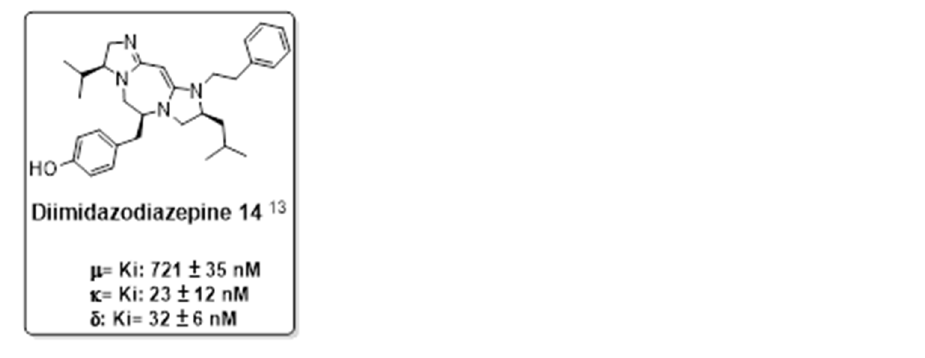
Figure 1. Structure and opioid receptor affinity of the diimidazodiazepine, 14 (from ref 13